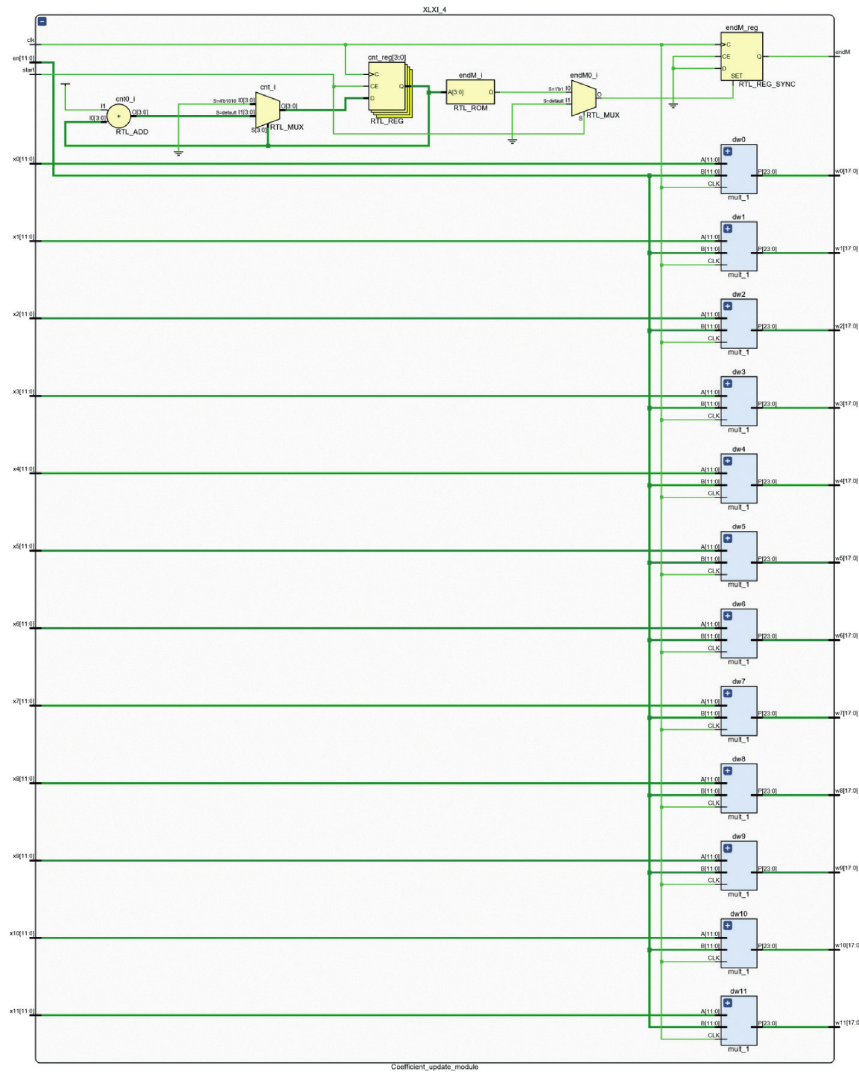
Figure 14: Integrated circuit diagram of the coefficient update module.